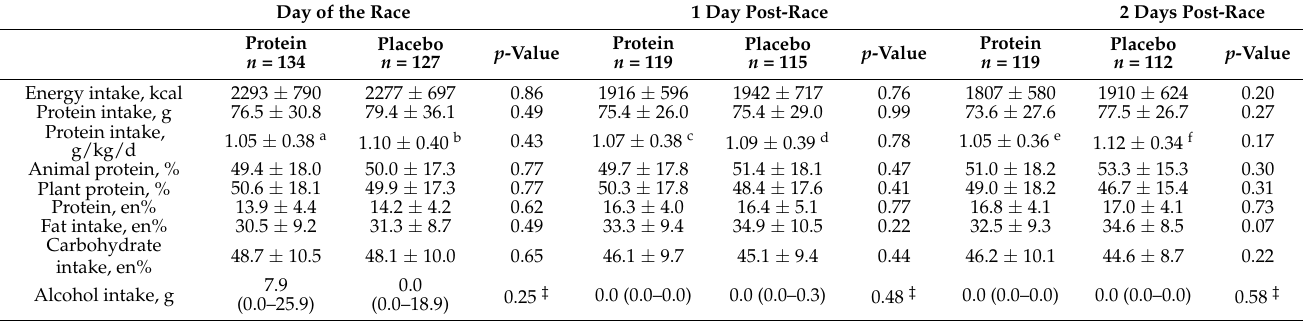
Table 2. Habitual dietary intake of participants in the protein and placebo group (disregarding supplements), based on ITT. Day of the Race 1 Day Post-Race 2 Days Post-Race Protein Protein Protein Placebo Placebo Placebo n = 134 n = 119 n = 119 n = 127 p -Value n = 115 p -Value n = 112 p